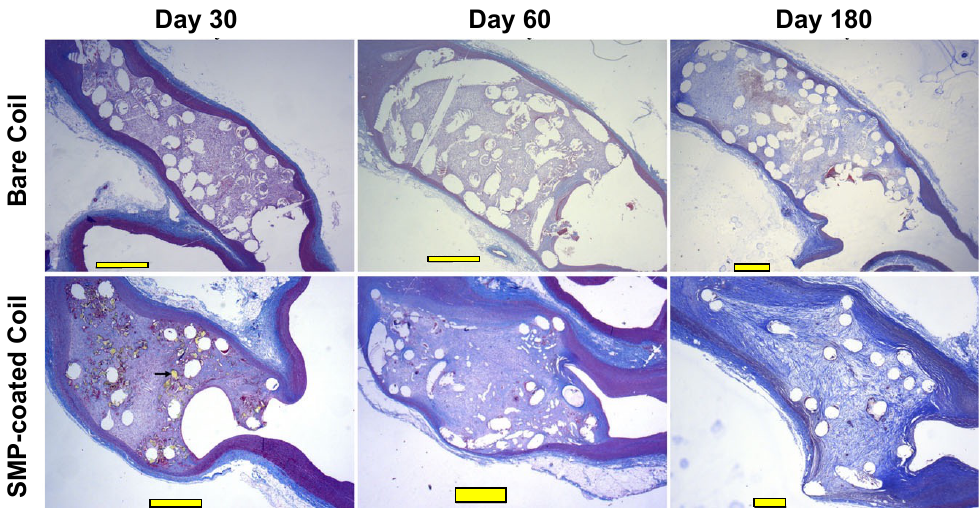
Figure 4. Histological analysis of embolized aneurysms with bare coils vs. SMP-coated coils in a rabbit model. Staining was performed using Masson’s Trichrome at different timepoints (30, 60 and 180 days post-implantation) in this pre-clinical study. Scale bars = 1mm. (Images were adapted from Herting et al. [19] with permission of John Wiley &